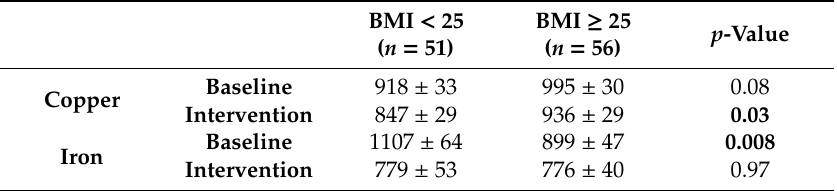
Table 4. Copper and iron concentrations in subjects divided by BMI into normal weight ( < 25 kg / m 2 ) or overweight and obese ( ≥ 25 kg / m 2 ) groups. An unpaired, two-tailed t -test was used to analyze significance between BMI groups. Mean ± SEM are